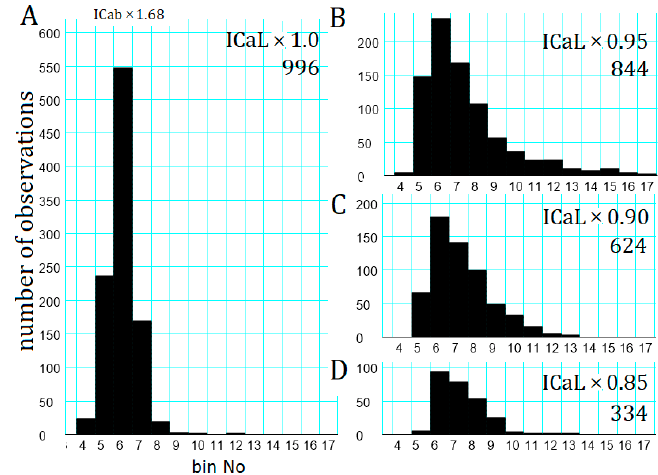
Figure 6. Latency histogram of the initiation of repetitive AP TD generation at different amplitudes of I CaL . The latency was measured from the onset of NA application to the time of the initial fifth AP TD discharge within a train. Vertical and horizontal axes for ( B – D ) are the same as in ( A ). The bin width was 30 s. The amplitude of I CaL in each series of simulation is indicated at up-right corner of ( A – D ) together with the number of successful triggerings of the repetitive generation of AP TD s in 1000 trials.